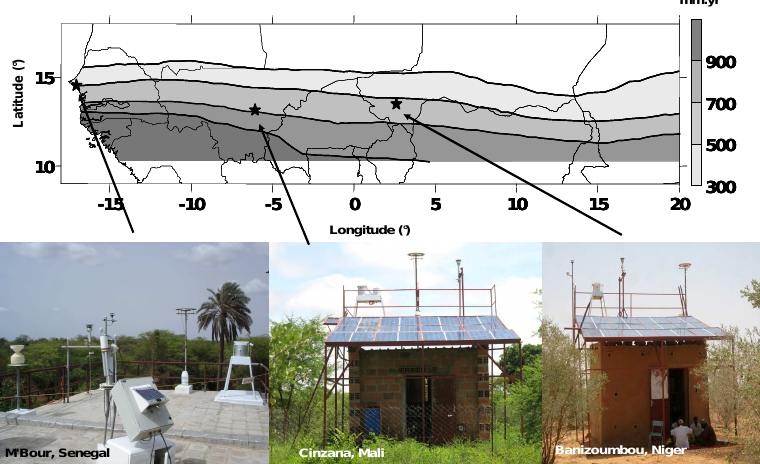
Fig. 1. Location of the three experimental sites compared to the annual precipitation rates over West Africa (figure adapted from Lebel and Ali, 2009) and views of the aerosol sampling stations of Banizoumbou (Niger), Cinzana (Mali) and M’Bour (Senegal).